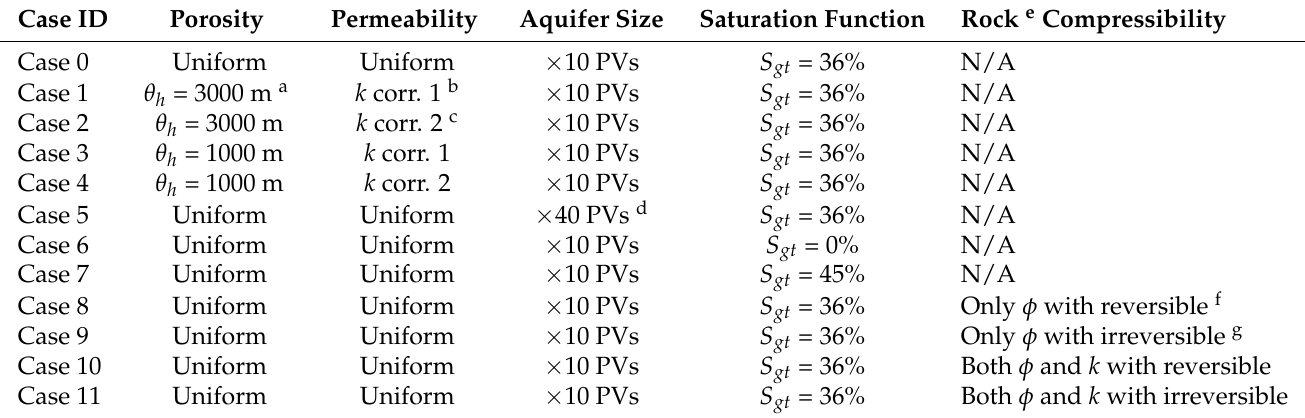
Table A1. Description of 12 simulation cases from cases 0 to 11 used in the study on the CO 2 storage capacity, as described in Section 3 of the main text.